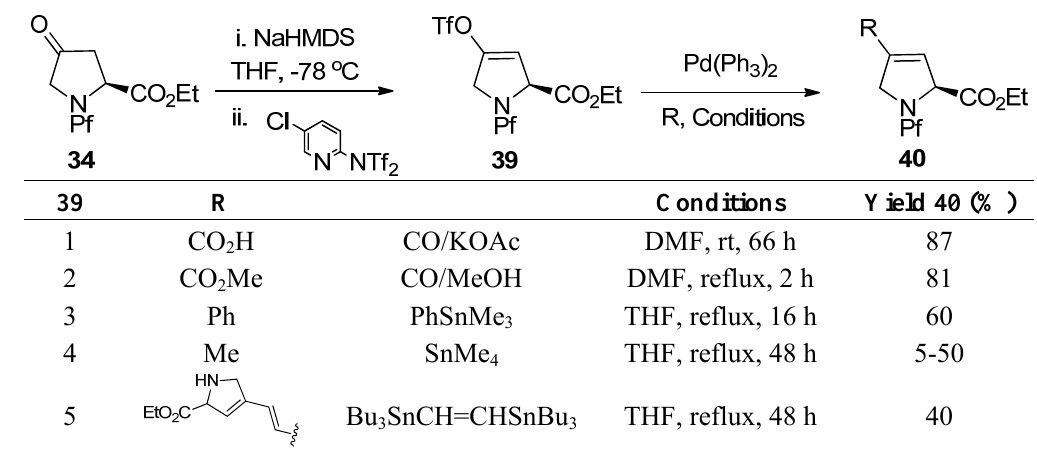
Table 6. Synthesis of